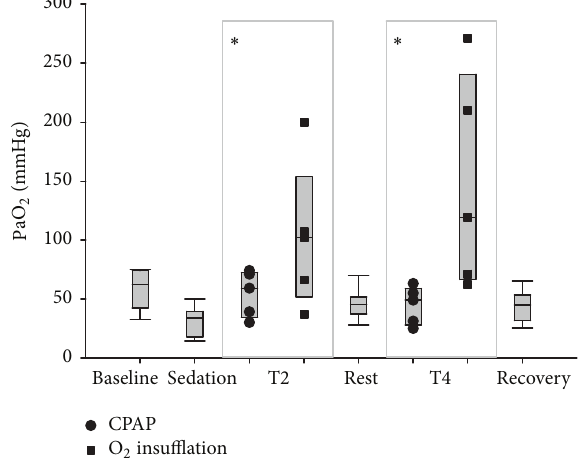
Figure 2: Arterial partial pressure of oxygen (PaO 2 ) following respiratory support by oxygen insufflation or continuous positive airway pressure (CPAP). Values are shown as median (horizontal line) and quartiles and range immediately after catheter placement (T0, baseline), 10 minutes following sedation (T1, sedation), fol- lowing 10 minutes of oxygen supplementation (O 2 ), following 10 minutes of CPAP, and after 10 minutes of breathing ambient air followingrespiratorysupport(T3,rest,andT5,recovery).Individual results following respiratory support (CPAP or O 2 insufflation) are shown at T2 and T4. Order of respiratory support at T2 (CPAP or O 2 insufflation) was randomly assigned to replicate groups of paired calves. The alternate treatment (O 2 insufflation or CPAP) was administered at T4. Values obtained following O 2 insufflation were significantly greater than values obtained following sedation ( 𝑃 < 0.05 ). Treatment order had no significant effect on response to O 2 supplementation or